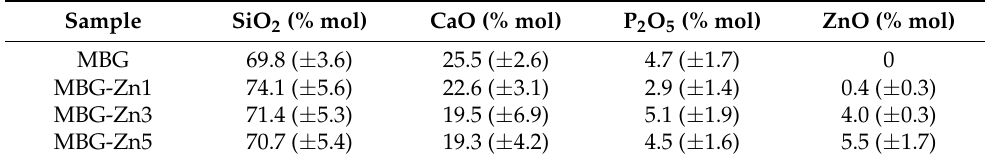
Table 1. Chemical composition (% mol) calculated by EDX spectroscopy.